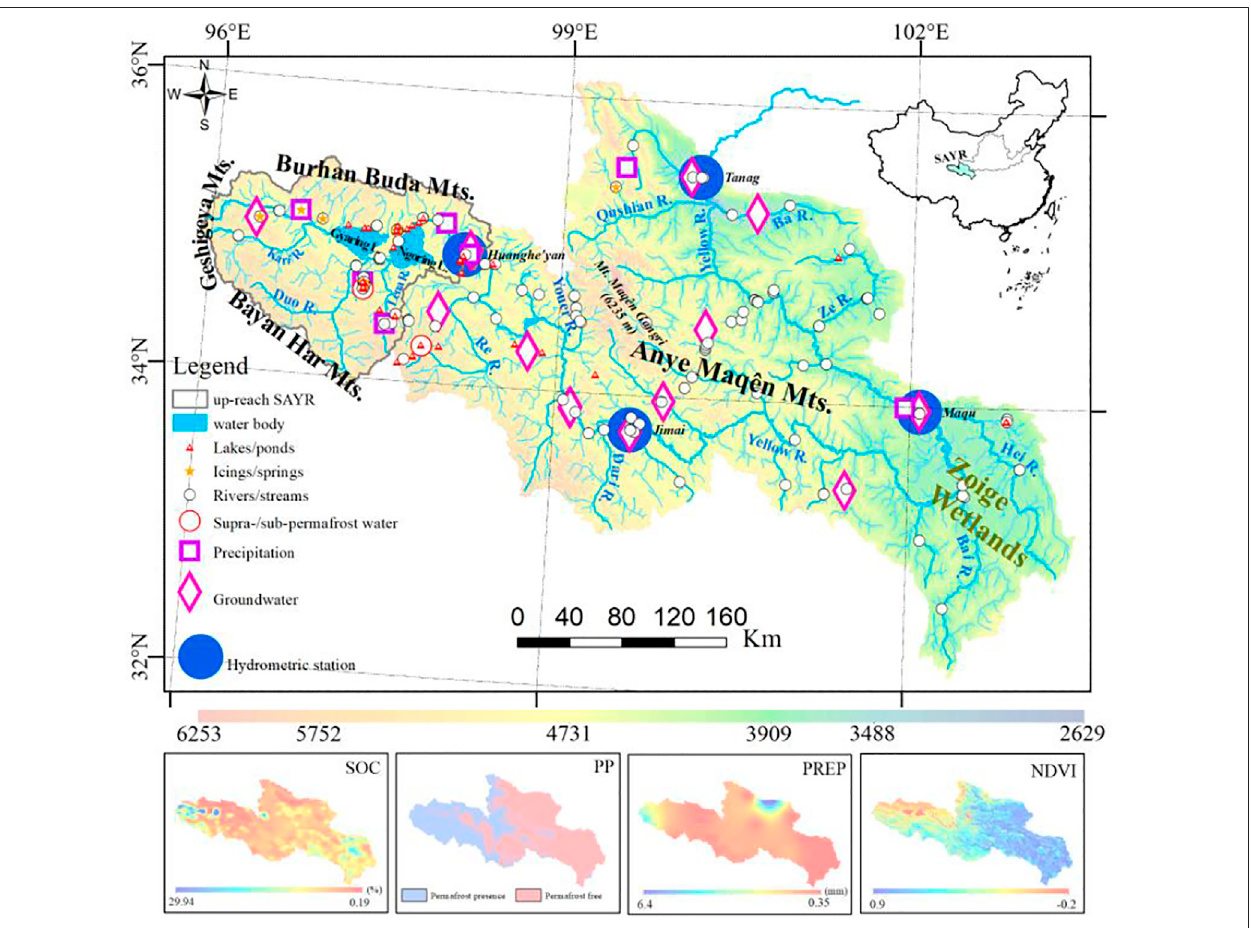
FIGURE1| Map ofsamplinglocationsinthesource areaoftheYellow River (SAYR)onthenortheasternQinghai – TibetPlateau,SW China. Notes: Sub-panel SOC shows the spatial distribution of soil organic carbon (SOC) content; sub-panel PP shows the distribution of permafrost presence; sub-panel PREP is the distribution of daily precipitation on 12 August 2016; and sub-panel NDVI is the normalized difference vegetation index on 12 August 2016.